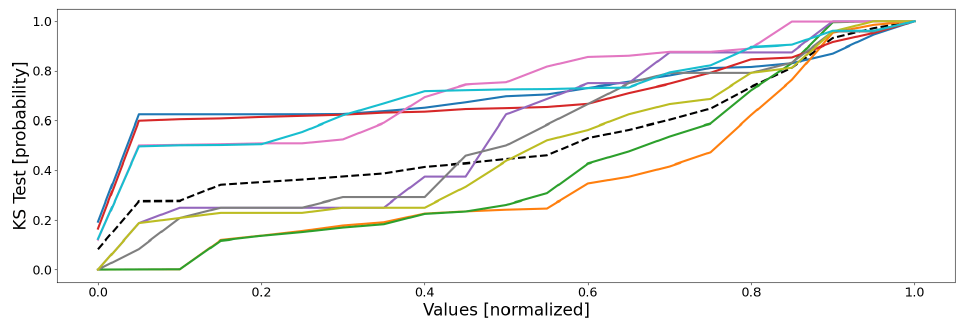
Figure 6. Battery 1 mean probability distributions computed along each dimension (sensor). The solid color lines are those of the clusters, and the dashed black line is that of the database. Normalized sensor values in abscissa and empirical probability of appearance in the